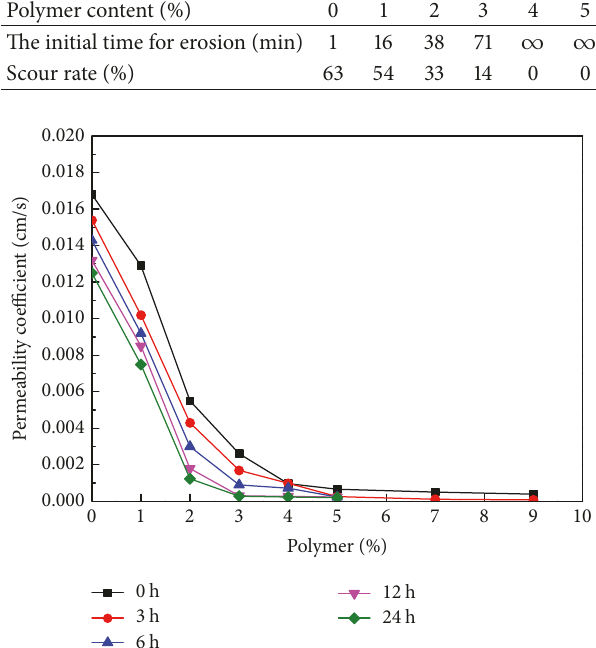
Figure 9: The permeability coefficient of the